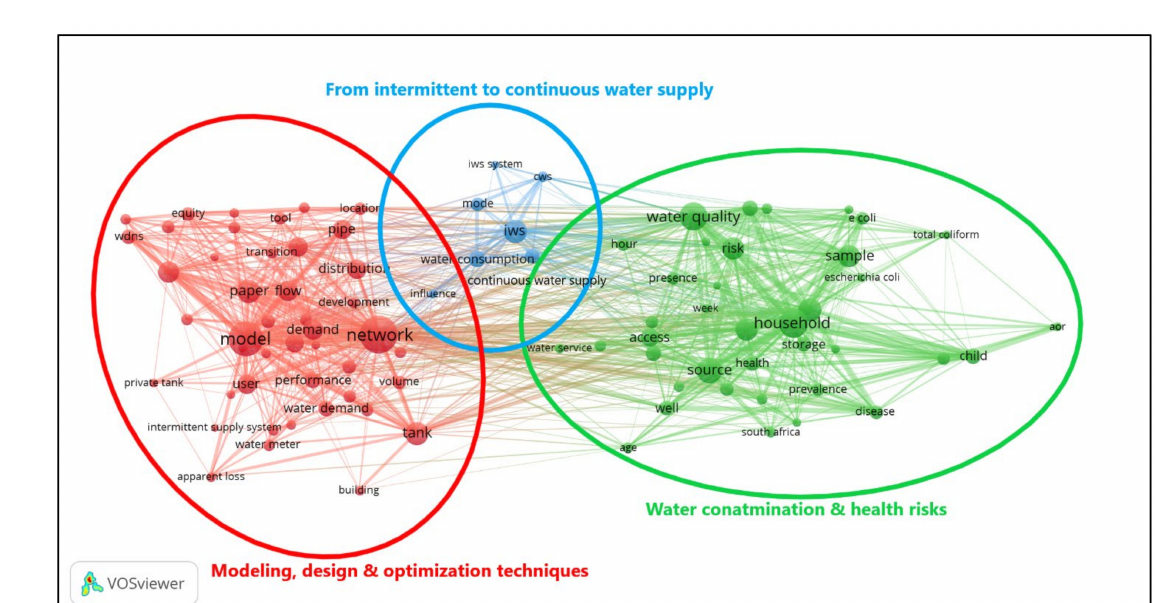
Figure 11. The network visualization map of terms co-occurrence in titles and abstracts. Ten occur- rences of a term were set as the minimum number. A total of 152 terms met the set threshold out of 5268 terms. A relevance score was set to assess the most relevant terms: 60%. The selected terms were the most relevant: 91 terms were categorized into 3 major